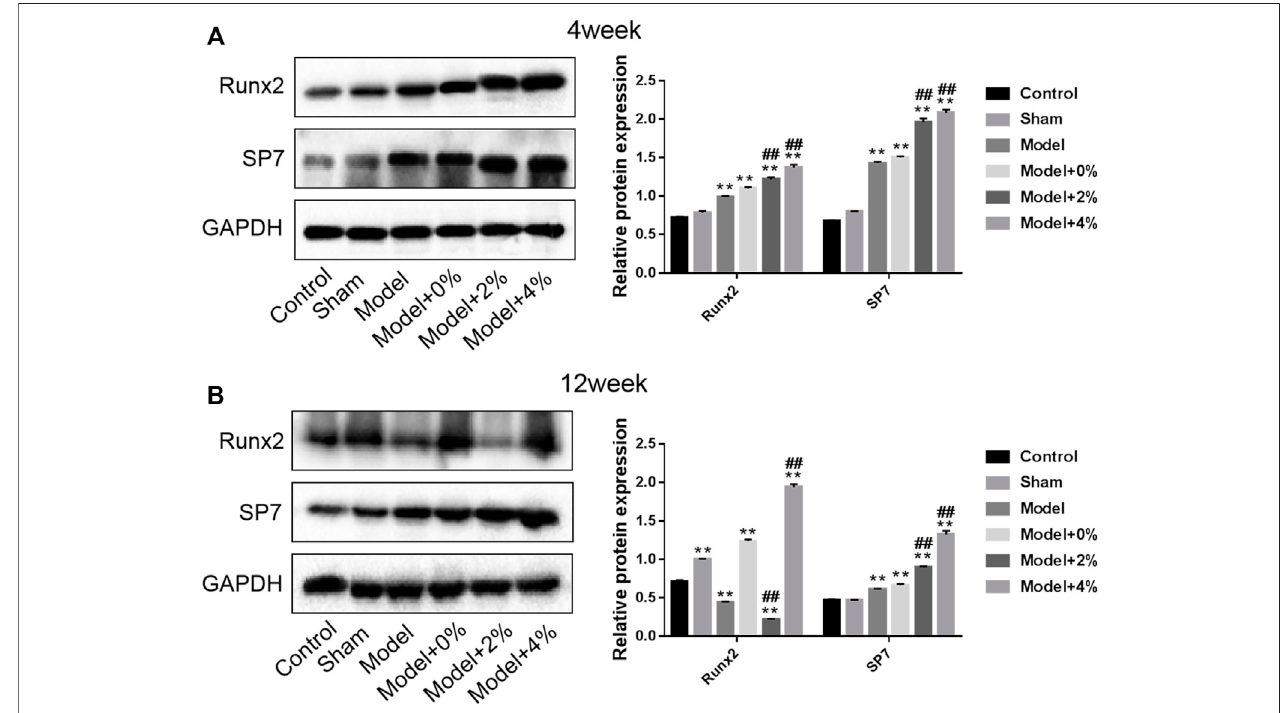
FIGURE 6 | Western blot analysis for determination of the expression of Runx2 and SP7 protein at 4 and 12 weeks. Compared with the Control group, ** p < 0.01; compared with the Model group, ## p < 0.01.